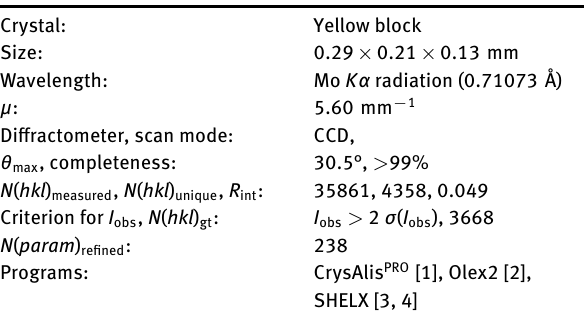
Figure 1: The molecular structure of (I), with displacement ellipsoids drawn at the 30% probability level.